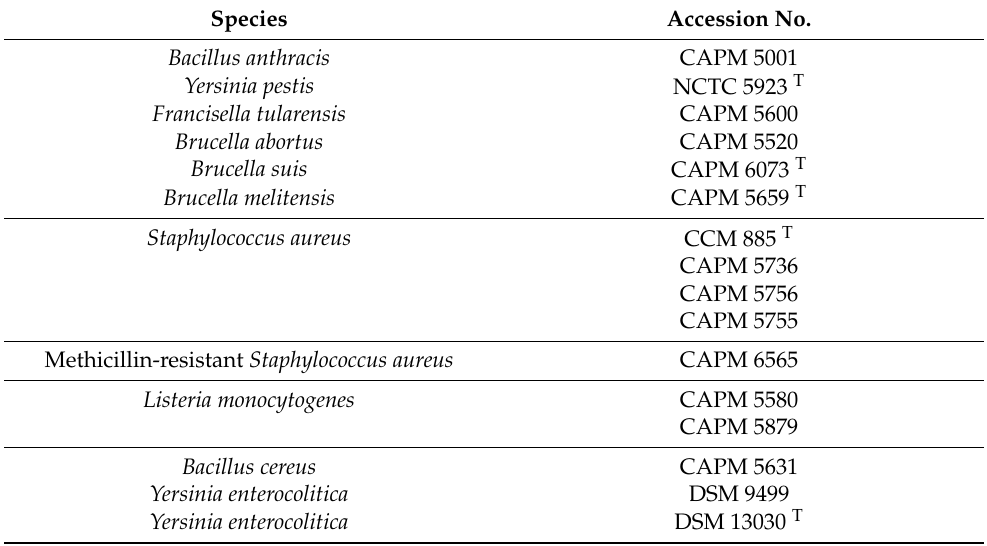
Table 1. List of bacteria used in this